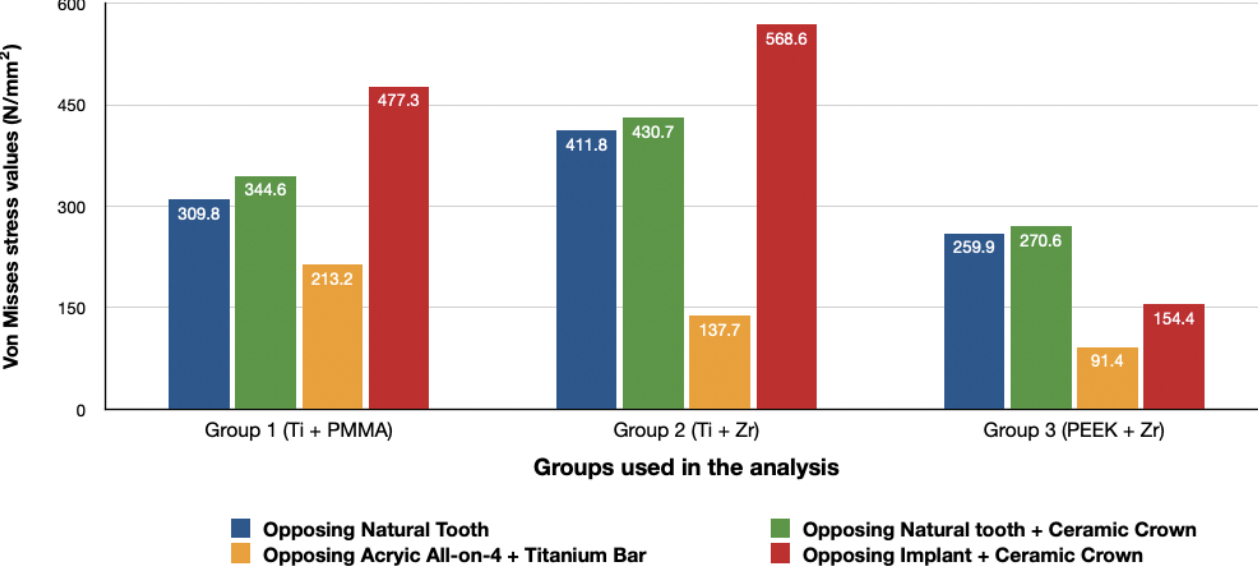
Figure 16. Values of Von Mises stresses on Framework under loads.